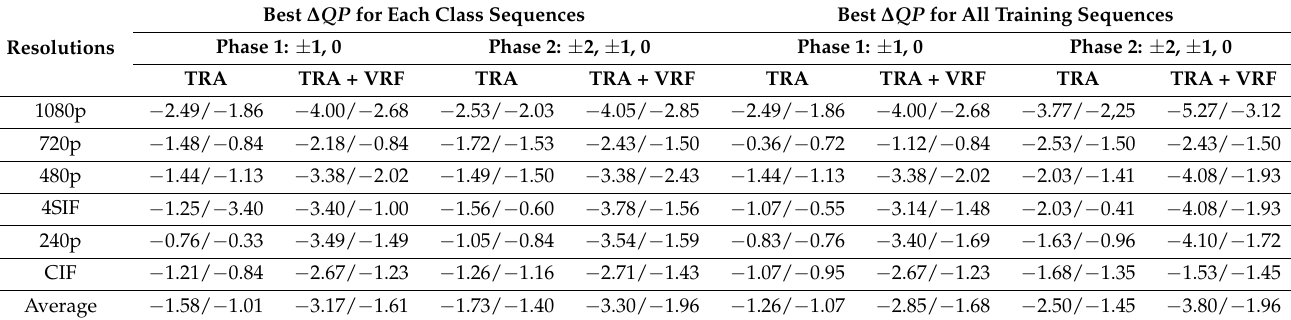
Table 2. Training performance (Y-BDBR % at low rate/high rate).